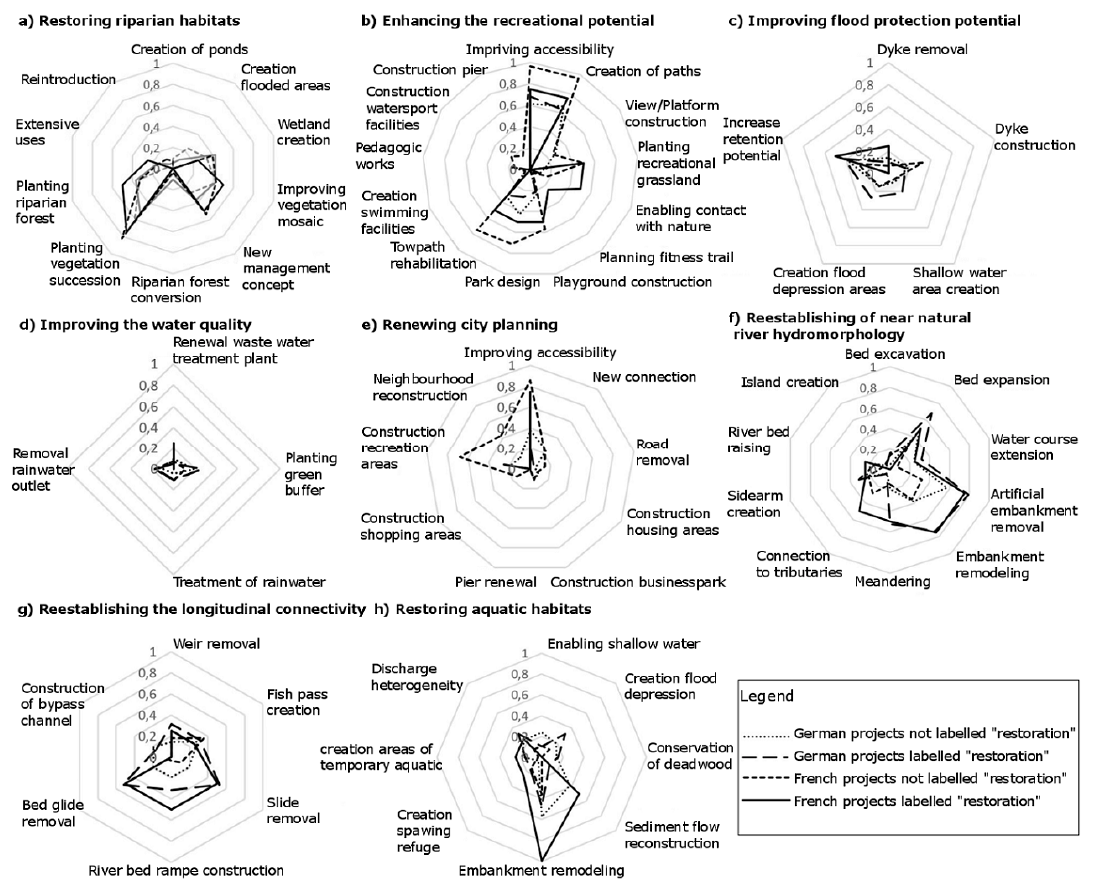
Figure 3. Frequency of implementation of the restoration measures regarding restoration goals, title